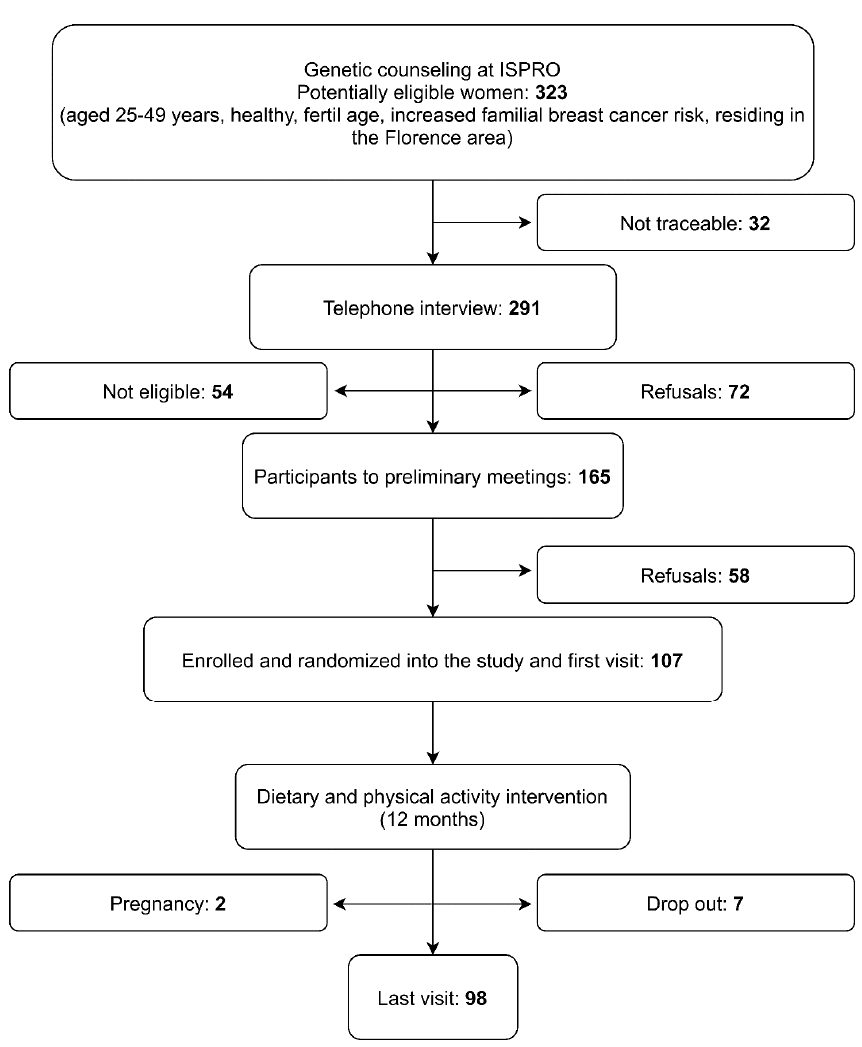
Figure 1. Flow chart of the DAMA25 Study (Trial Registration Number: ISRCTN54262307).